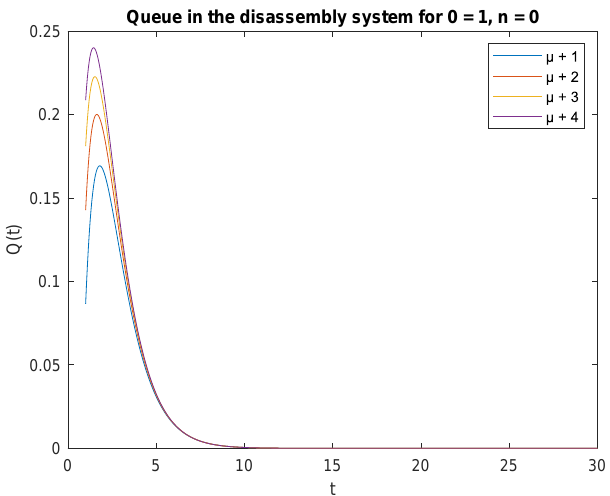
Figure 16. Impact of disassembly rate on probability P { X ( t ) = m = 0 | X ( 0 ) = n = 0 } for λ = 1.